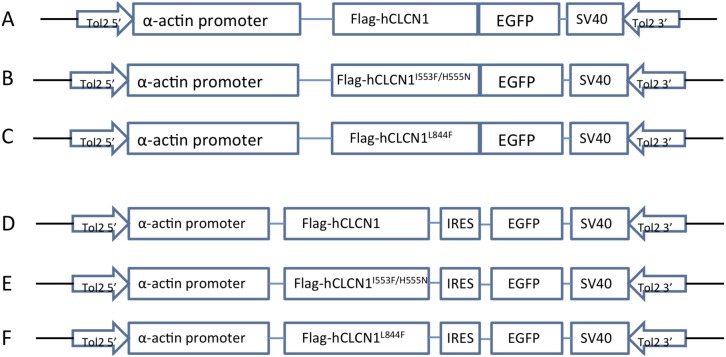
Maps of α-actin:hCLCN1-EGFP and α-actin:hCLCN1-IRES-EGFP constructs used in this study.(A–C) Three constructs expressing hCLCN1, hCLCN1I553F/H555N, and hCLCN1L844F –green fluorescent protein (EGFP) fusions under the control of the α-actin promoter were used to produce stable transgenic zebrafish lines. EGFP was fused to the C-terminus of the flag-tagged hCLCN1. The Tol2 vector sequences are shown as thick black lines. (D-E) Three constructs expressing hCLCN1, hCLCN1I553F/H555N, hCLCN1L844F under the control of the α-actin promoter were used to produce stable transgenic zebrafish lines. An internal ribosome entry site (IRES) element is inserted in front of EGFP to allow simultaneous expression of hCLCN1 and EGFP protein separately but from the same RNA transcript. The Tol2 vector sequence is shown as thick black lines.